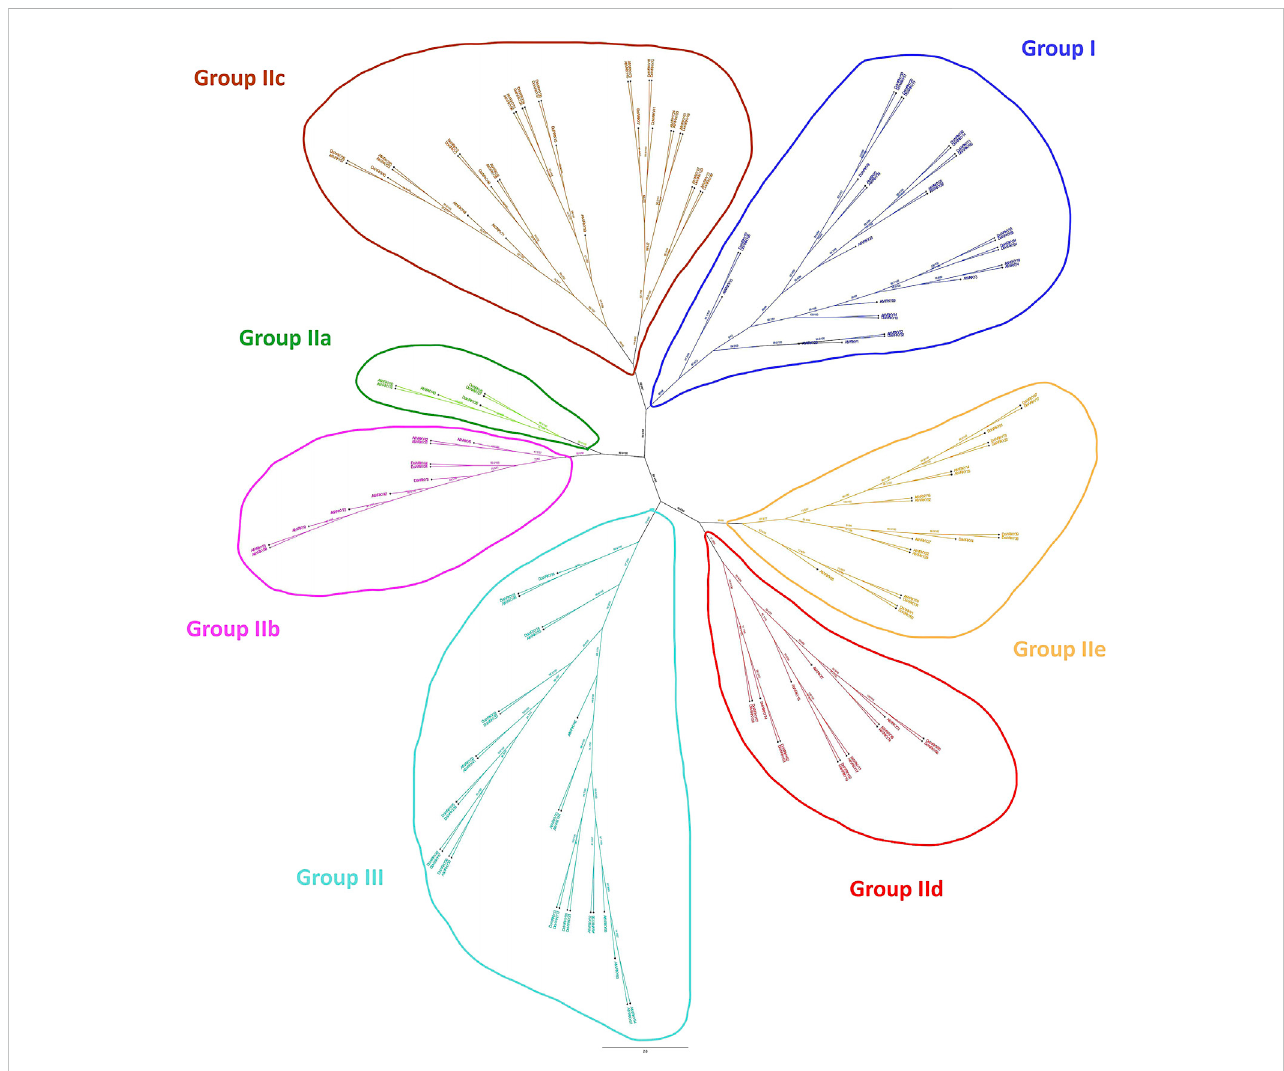
The phylogenetic tree of DoWRKYs and AtWRKYs by maximum likelihood